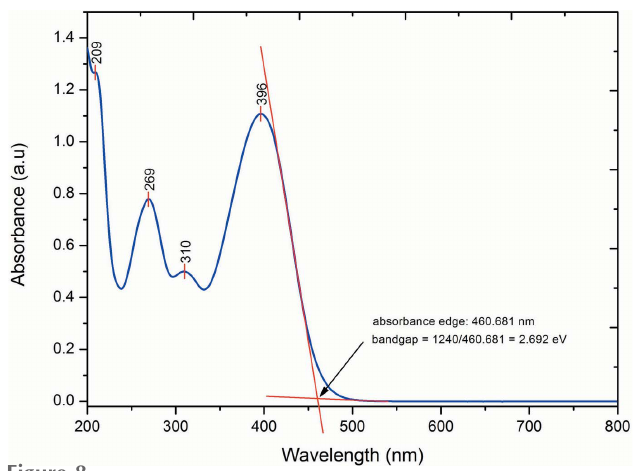
Figure 8 The UV–vis absorption spectrum of the title compound.